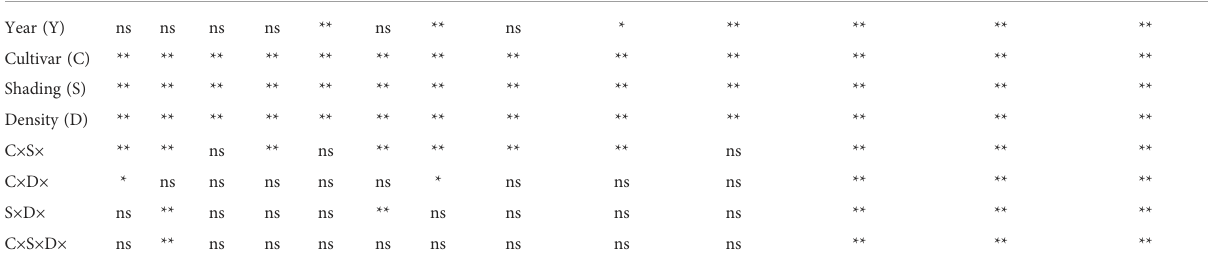
TABLE 2 Analysis of variance of the effects of year (Y), cultivar (C), shading (N) and density (D) on breaking strength, morphological characteristics, and lignin monomers composition of stems in wheat at milk stage. Source of